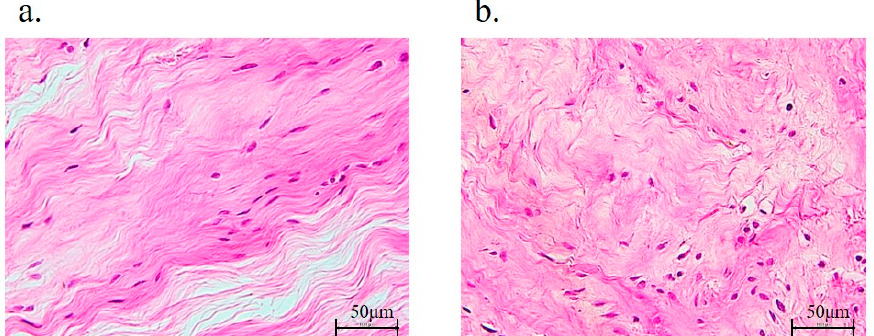
Figure 6. Rotator cuff histology. Hematoxylin and eosin staining of the supraspinatus tendons of non-diabetic controls ( a ) or diabetic group ( b ).